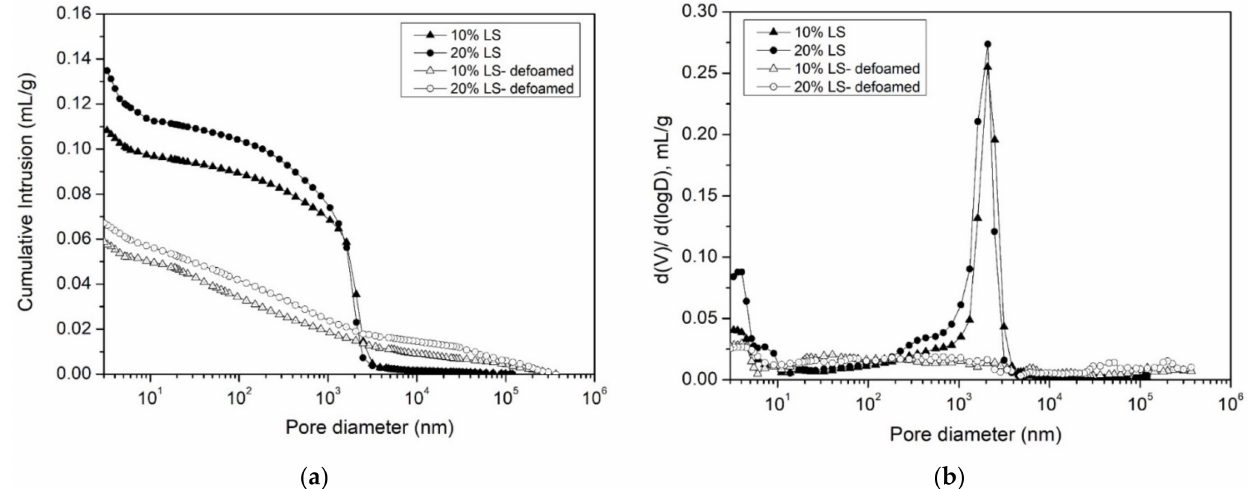
Figure 10. Mercury intrusion porosimetry (MIP) results on MAPC mortar samples with limestone fines (LS) at content of 10% and 20% with or without defoaming treatment by the compound use of 0.3% polyether modified silicone (PMS) defoamer and 1% Portland cement (PC): ( a ) Cumulative intrusion; ( b ) differential pore-size